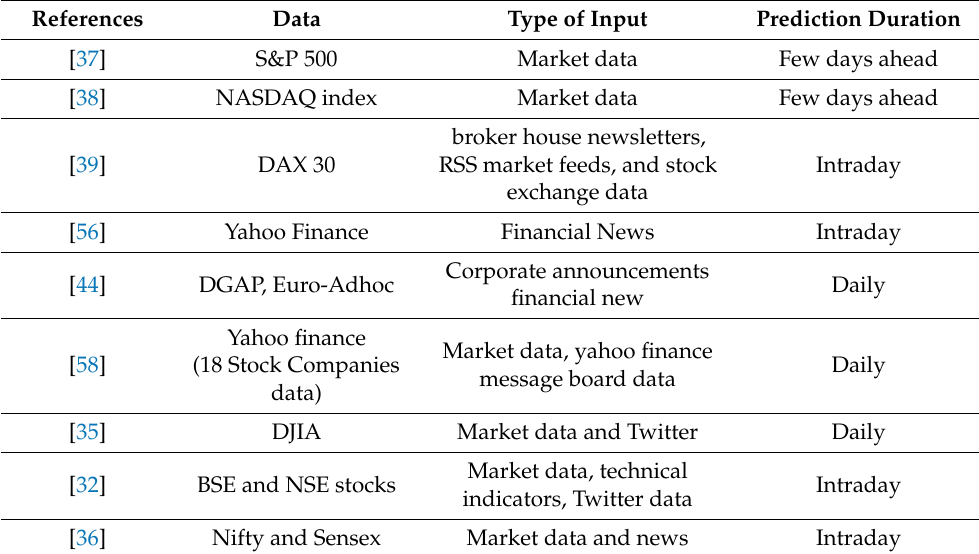
Table 1. Comparison of the data sources, type of input and prediction